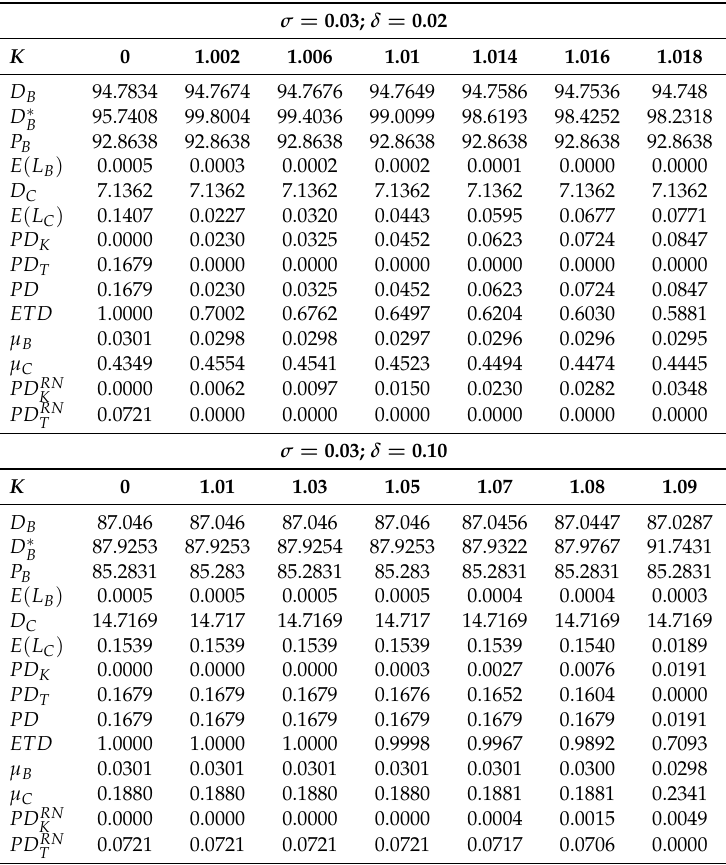
Table 5. SIV outcomes when risk control K is varied. The fire sale discount takes two values δ = { 0.02,0.10 } and the price of debt is fixed across all cases to the price of debt when K = 0, and D B = 0.99 D ∗ B